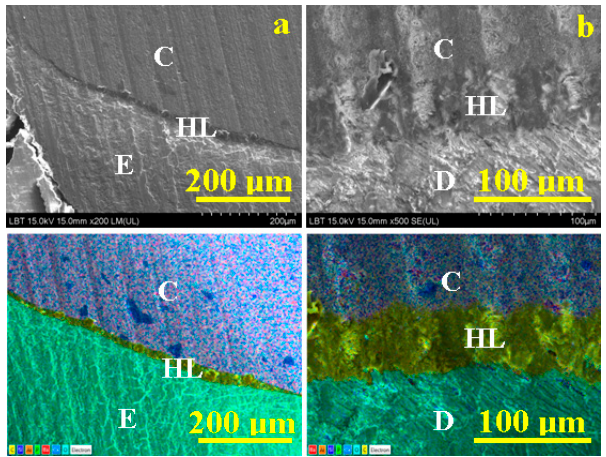
Figure 5. SEM images for Score 0 in Group A: ( a ) Composite (C)—enamel interface (E); ( b ) Composite (C)—dentin (D) interface; HL—hybrid layer. EDX mappings are given below for each SEM electron image.